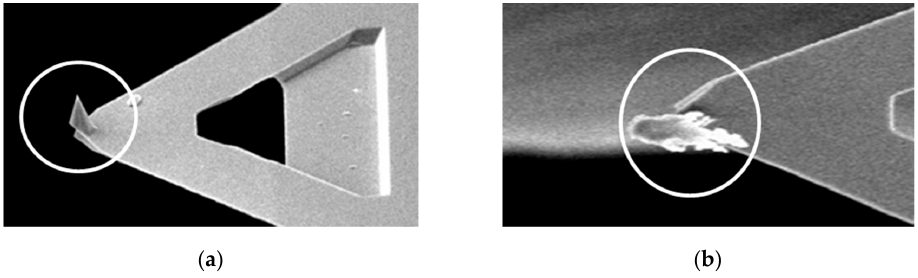
Figure 8. AFM probe. ( a ) Original probe; and ( b ) with C–S–H at the apex.